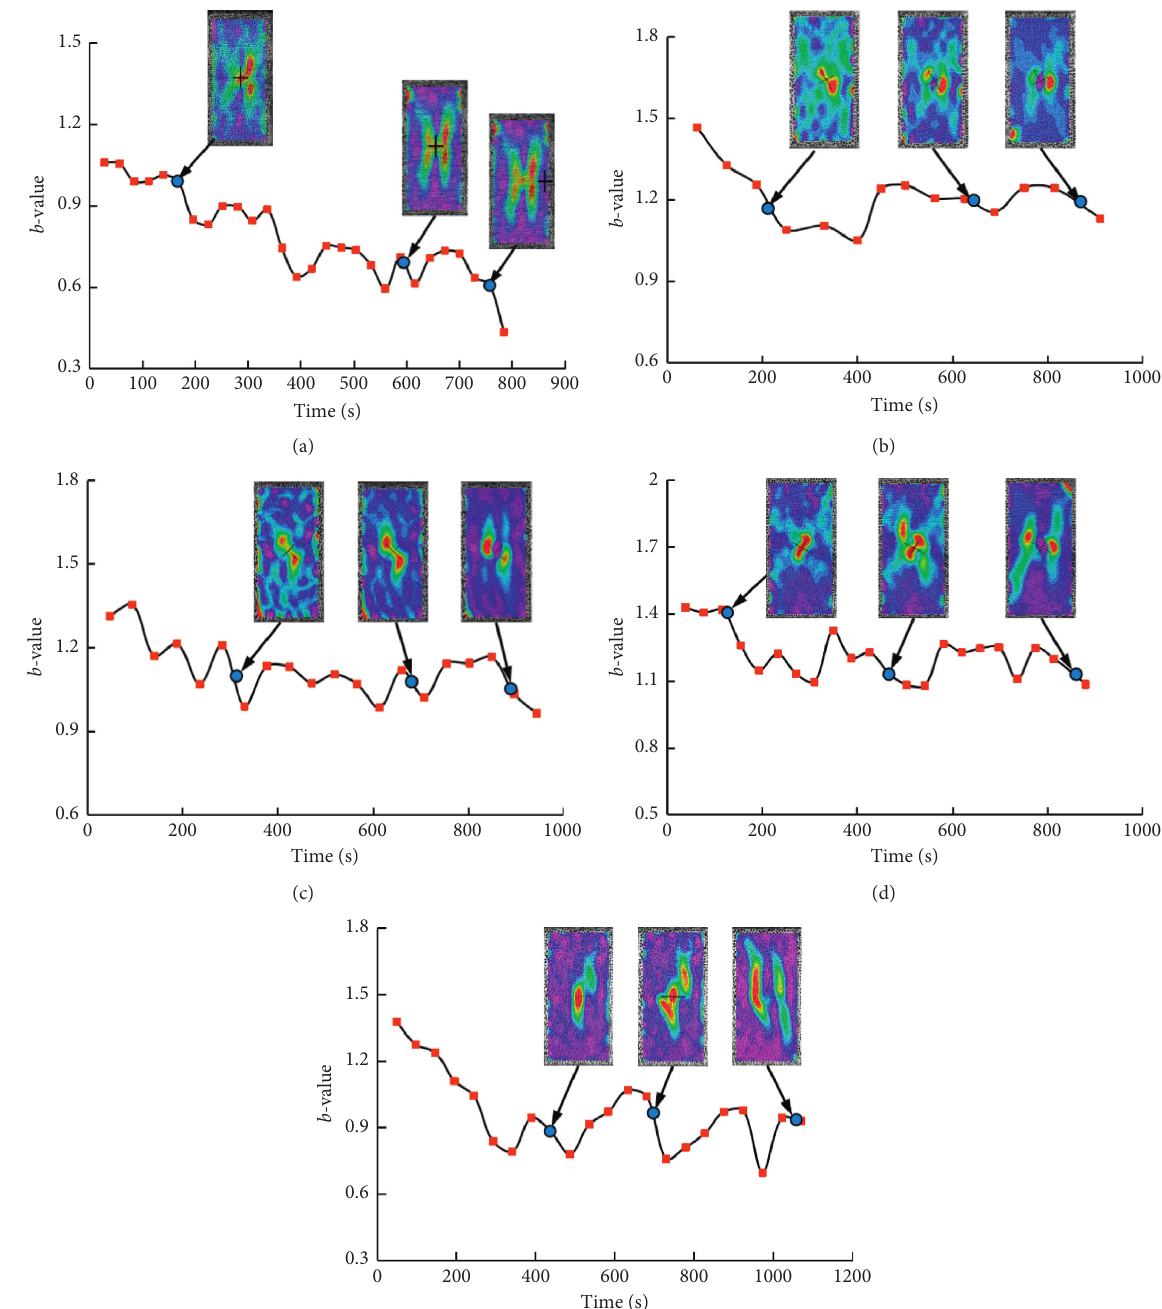
Figure 8: Cracking processes and b -value evolutions with time for the specimens with orthogonal cracks. (a) 00–90 (b) 30–90 (c) 45–90. (d) 60–90. (e)